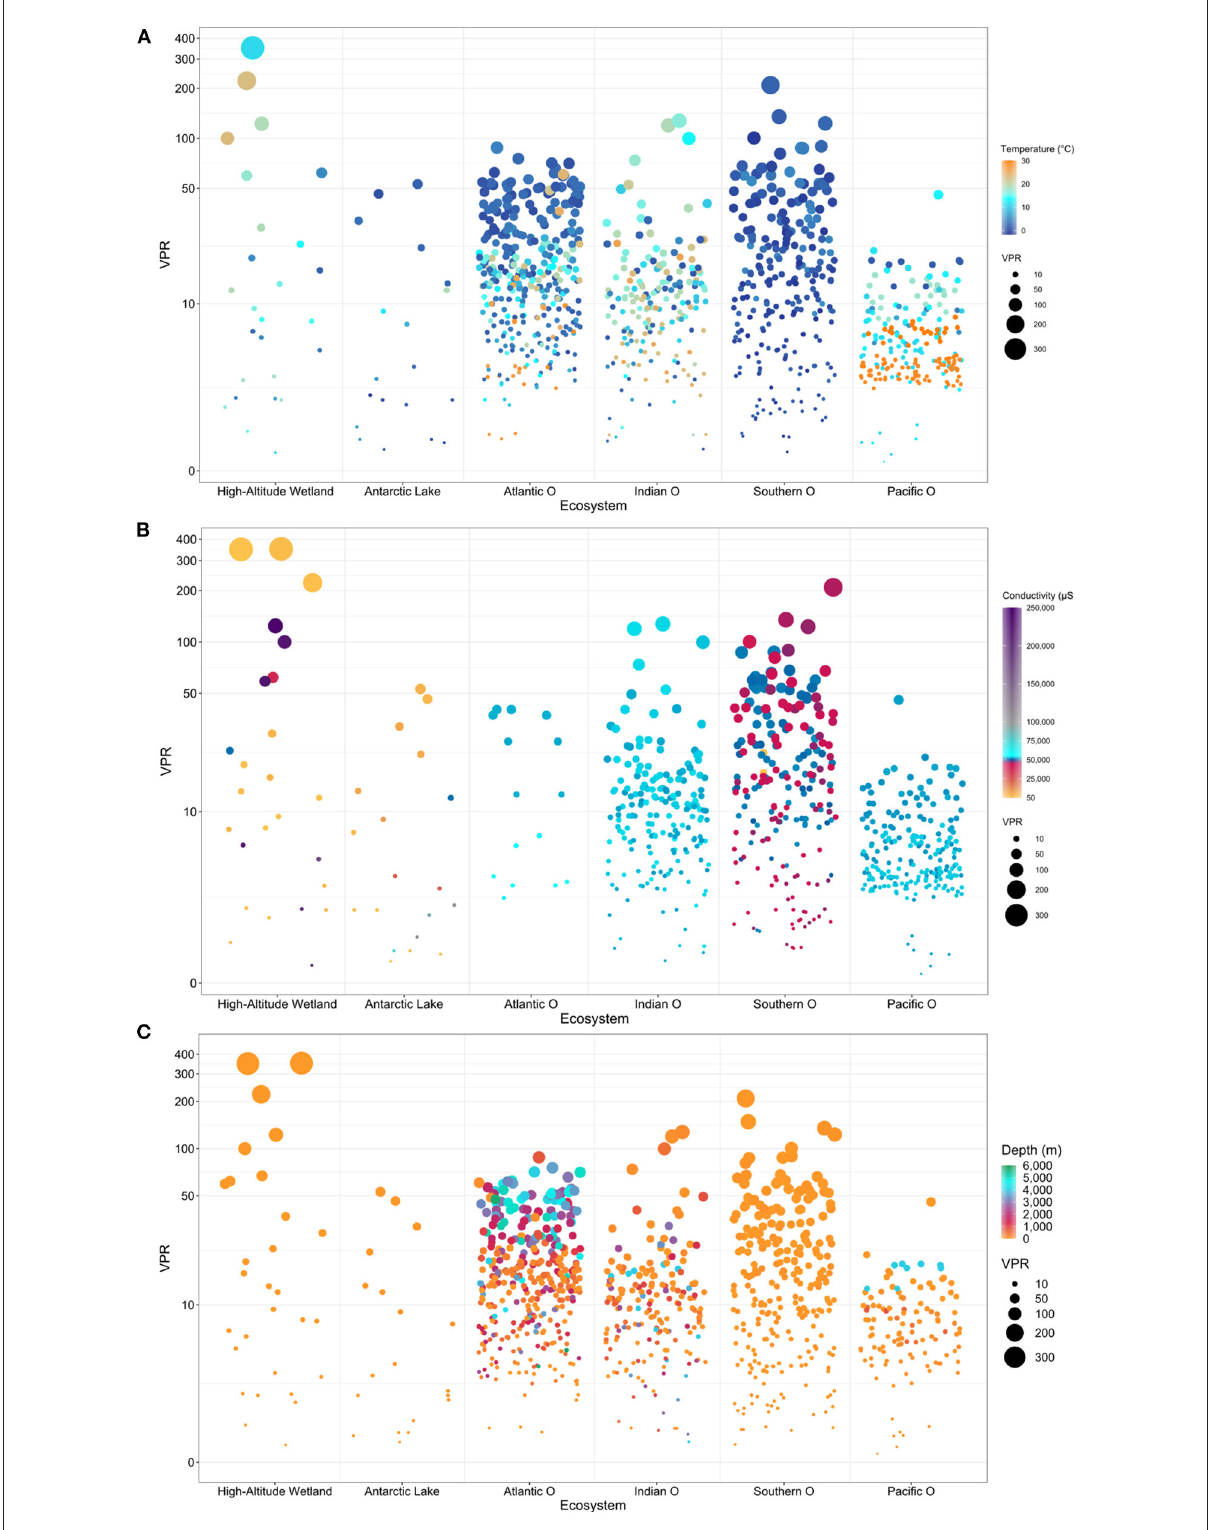
FIGURE7 Bubble plots analysis (A) Temperature (B) Conductivity and (C) Depth, showing the relationship between environmental variables and VPR values potentially relevant in the different ecosystems